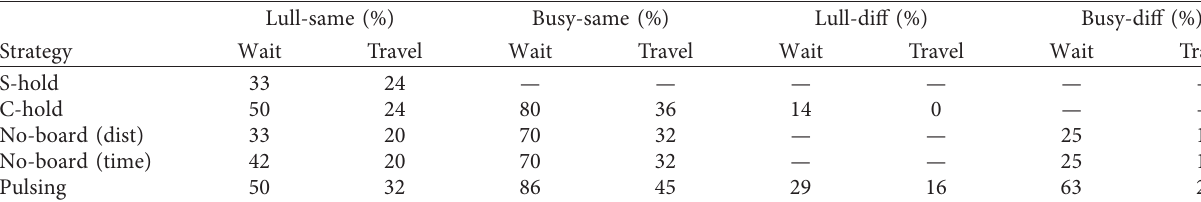
Table 6: Fractional savings in waiting time and travelling time (respectively, in two columns) taken in the four test scenarios, under the four different strategies. The waiting and travelling times of each strategy are represented by its best performing parameter and a null entry represents the control case outperforming the strategy at all parameter values. The fractional savings is given by the fractional difference between the average waiting/travelling time of the strategy and the control case.